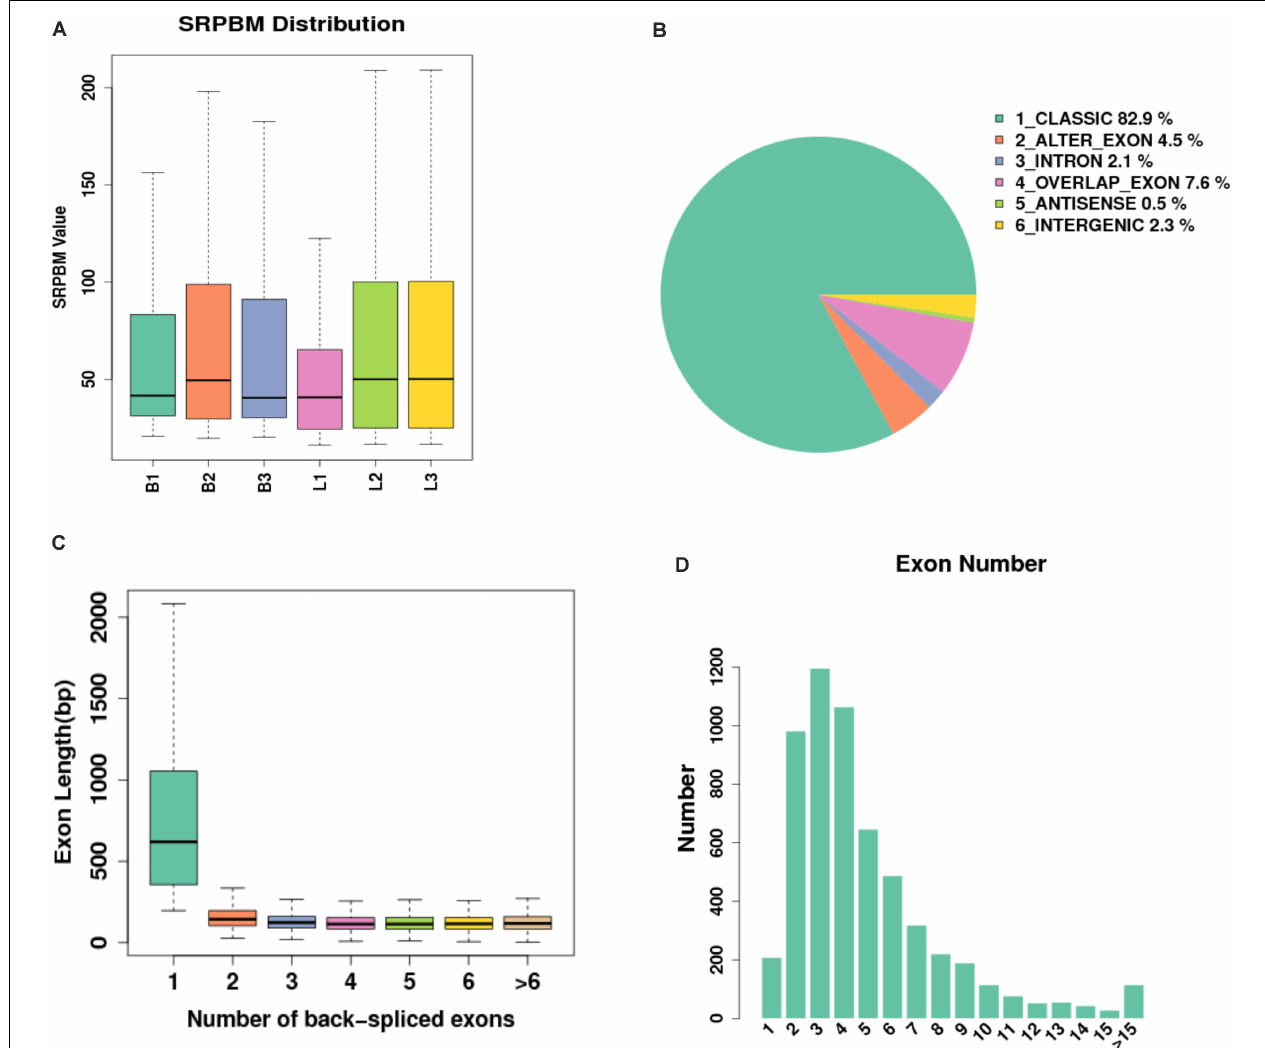
FIGURE 2 | Expression level of sample circRNAs. (A) SRPBM density: distribution density of circRNA expression in the sample; SRPBM value: the normalized count value of circRNAs, calculated by a formula (cid:2) SRPBM = (cid:0) SR × 10 9 (cid:1) / N (cid:3) in which SR is the number of spliced reads, and N is the total number of mapped reads in samples. (B) Distribution pie chart of the six types of circRNAs; (C) Box plot of the single exon length distribution of circular RNAs. The abscissa represents the number of exons contained in the circRNA, and the ordinate represents the length of a single exon; (D) The distribution of the number of exons contained in circular RNAs in the sample, the abscissa represents the number of exons, and the ordinate represents the number of circRNAs corresponding to the number of exons.